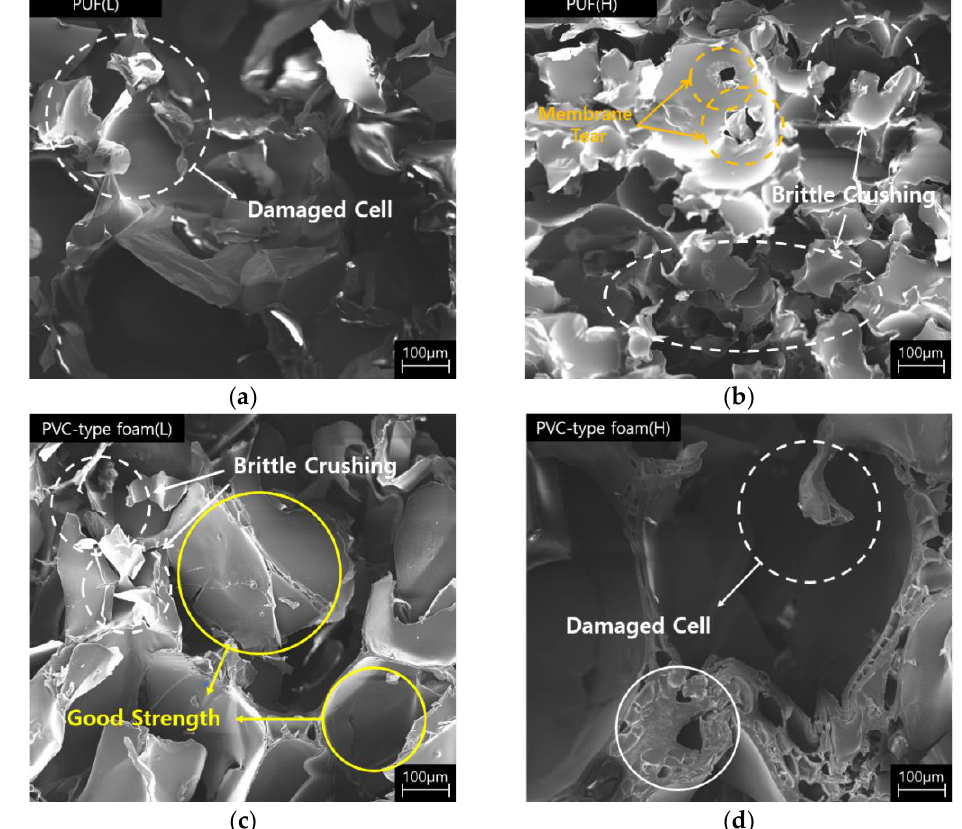
Figure 6. Micrographs of the specimens after the cryogenic compressive test ( −1 70 °C): (a) PUF(L), (b) PUF(H), (c) PVC-type foam(L), and (d) PVC-type foam(H).